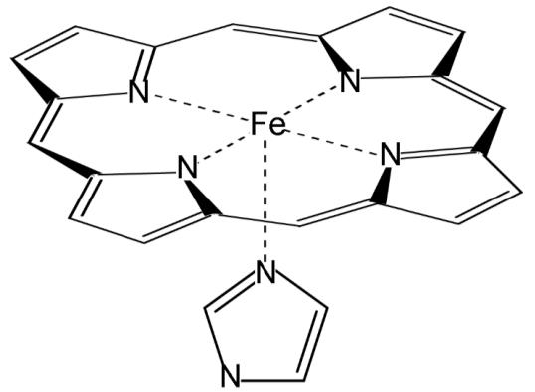
Figure 1. Molecular model of the active site of peroxidases.